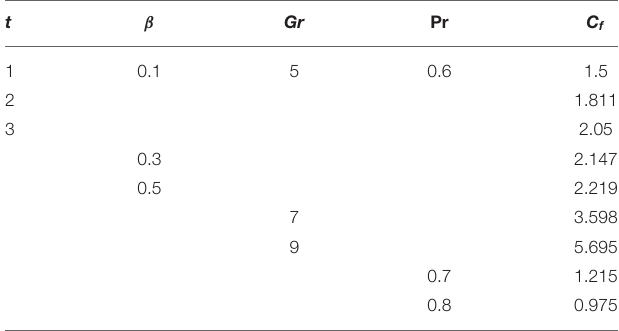
TABLE 1 | Effect of variation of different variables on C f .